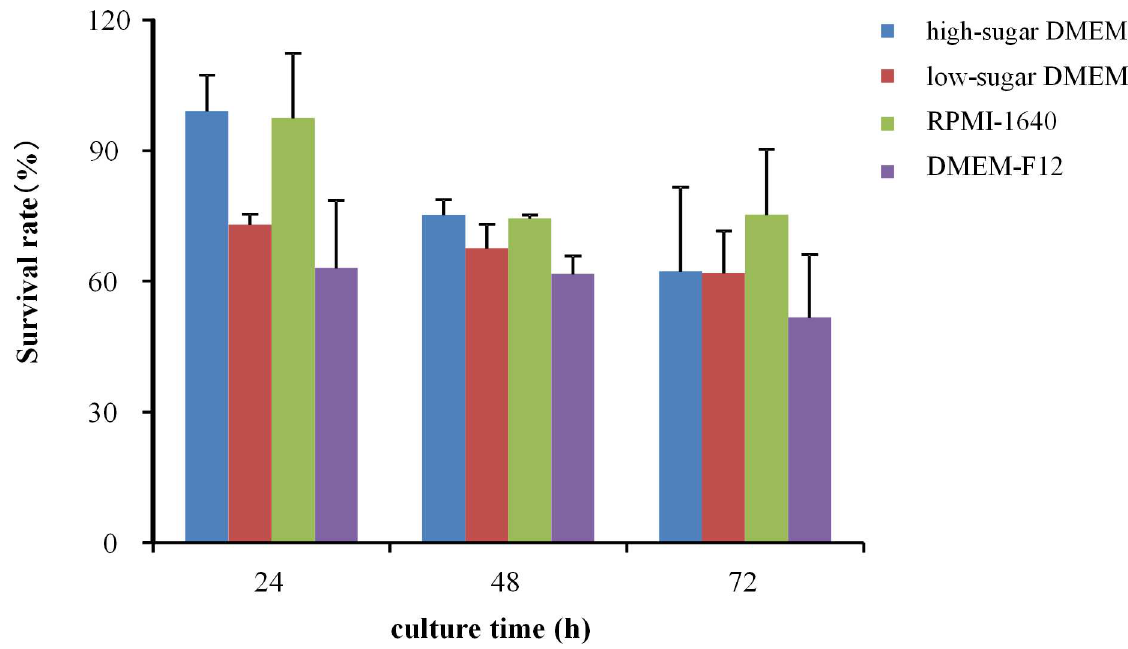
Fig 1. Coelomocytes survival rate in 72 h incubated under optimal culture